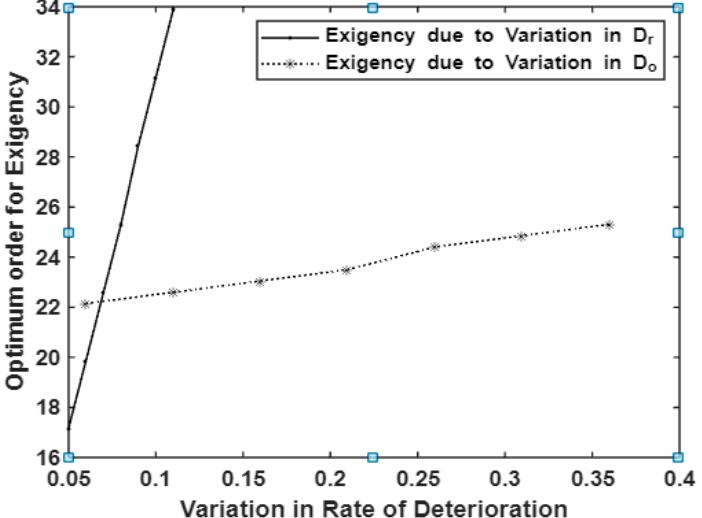
Figure 9. The effect of changes in deterioration rates 𝒟 (cid:3045) and 𝒟 (cid:3042) on optimal order for exigency.